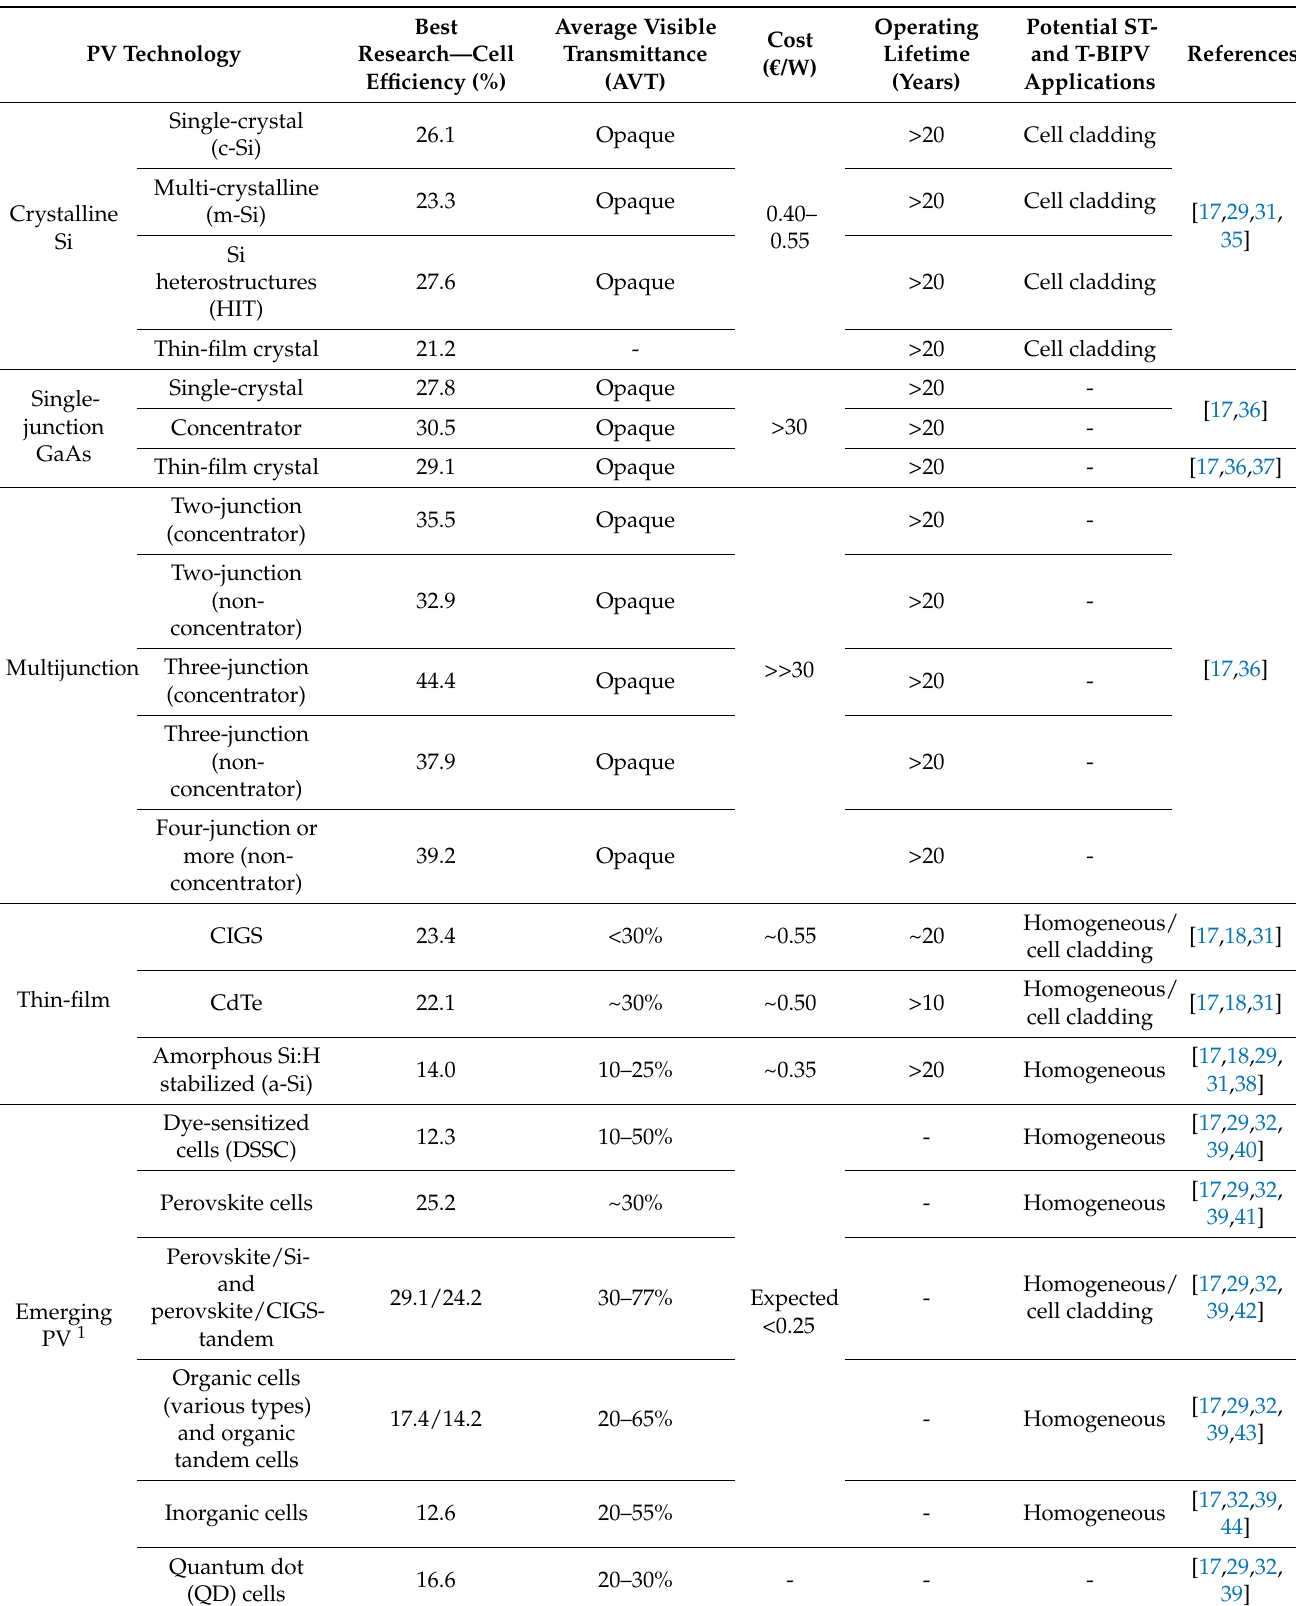
Table 1. Classification of PV technologies and properties relevant to